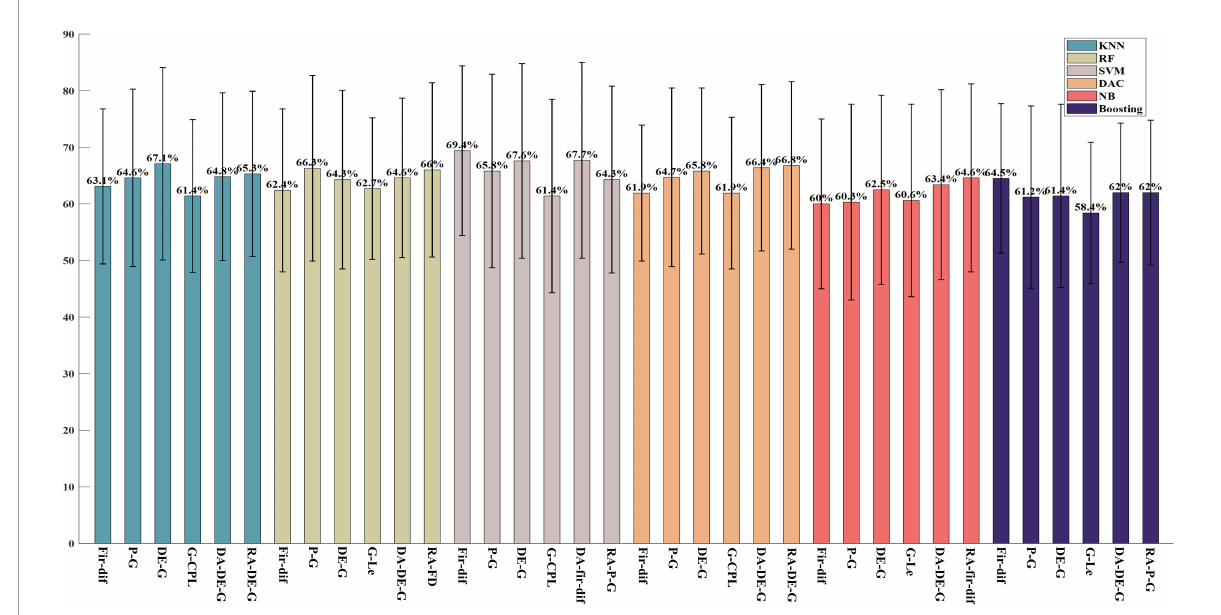
FIGURE3 The highest classification accuracy for high and low valence emotion in each feature domain on the DEAP. The block which including six bars of same color is the results of same classifier and from left to right, it is the classification results by classifiers KNN, RF, SVM, DAC, NB, and Boosting,